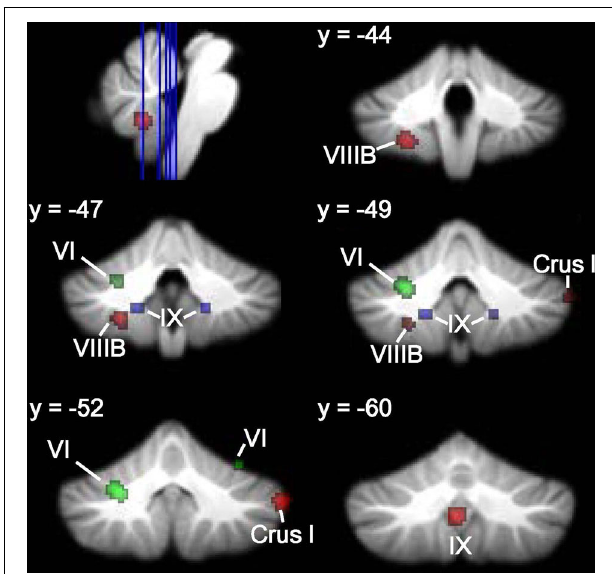
FIGURE 7 | Different cerebellar regions affected in ASD vs. ADHD vs. dyslexia in the cerebellar ROI analyses. Coronal, axial, and sagittal slices through the cerebellum show clusters of GM decreases in ASD (red), ADHD (blue), and dyslexia (green) resulting from the ROI